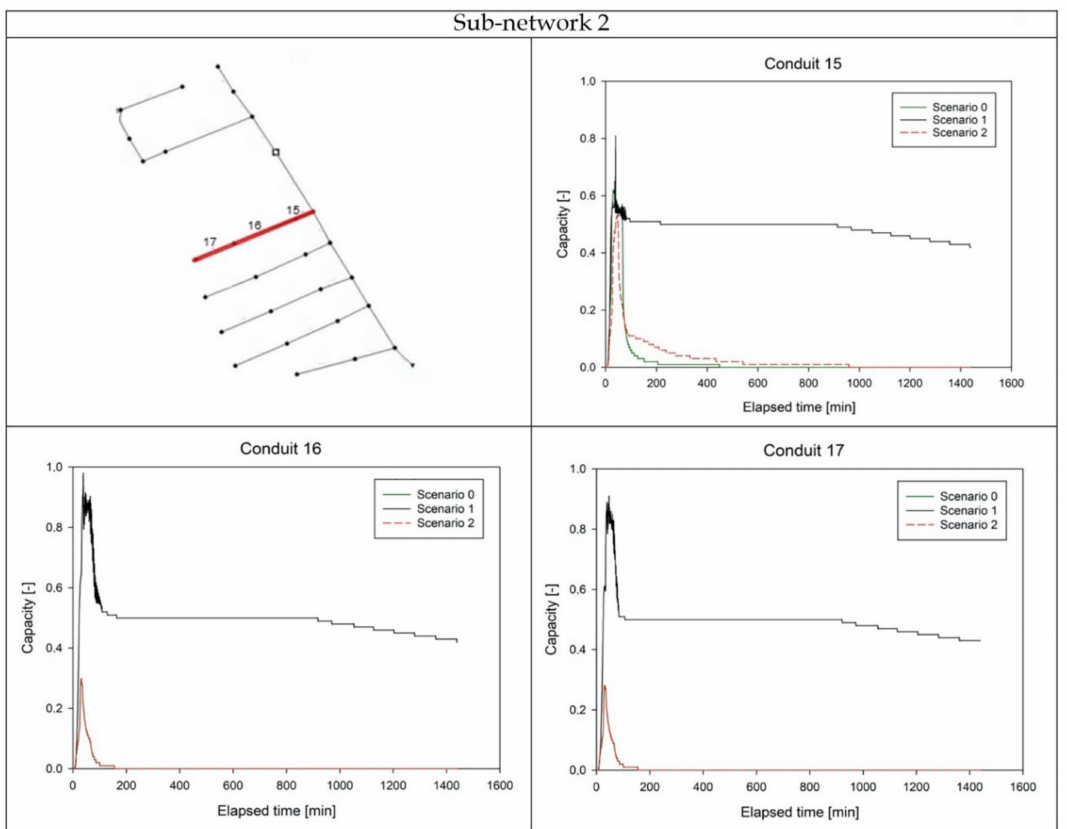
Figure A4. Conduits’ capacity in sub-network 2, highlighted in red in the first picture where the drainage network schematization is